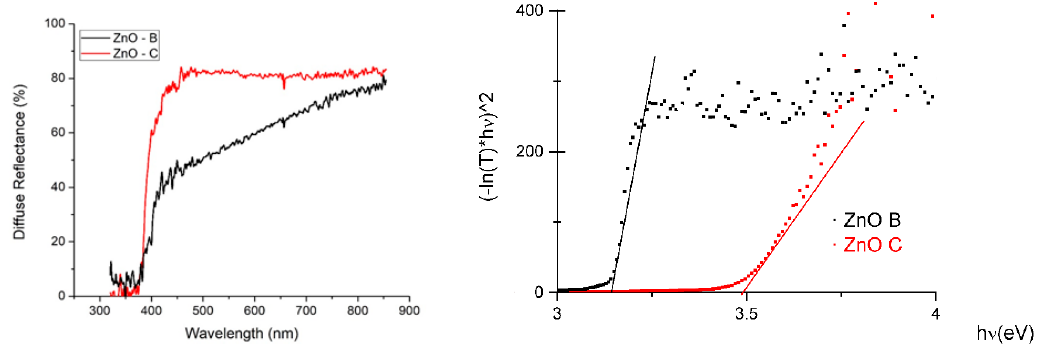
Figure 2. Diffuse ZnO reflectance plot (commercial and biomimetic). Tauc plot is shown on the right.